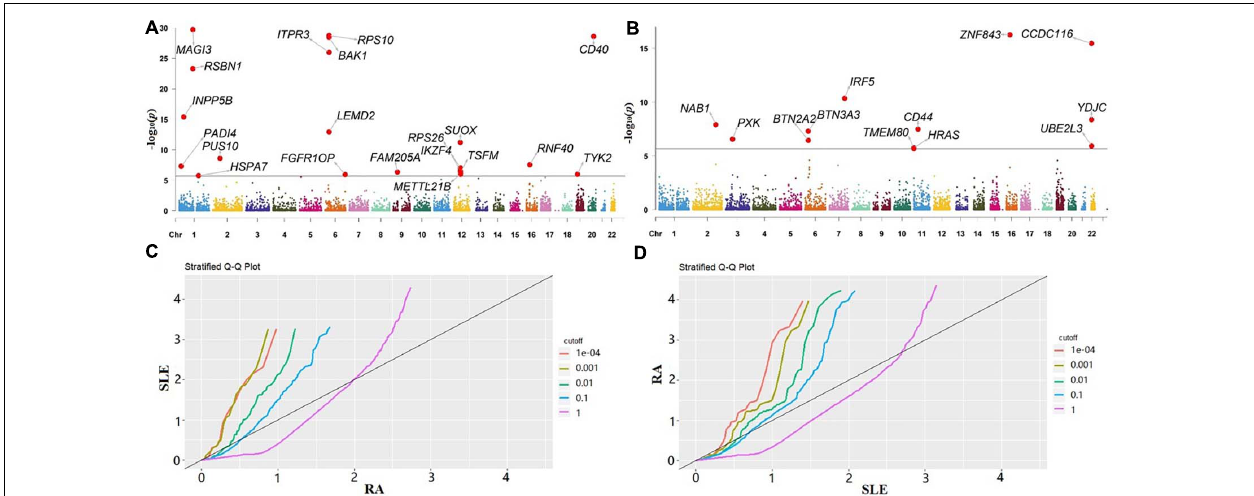
FIGURE 2 | (A) Manhattan plot for RA; (B) Manhattan plot for SLE. The genes in both plots with P -value < 2.1E-06 (the significance level adjusted by Bonferroni’s method) are highlighted; (C) Q-Q plot of RA conditional on the nominal P- value of SLE; (D) Q-Q plot of SLE conditional on the nominal P- value of RA. RA, rheumatoid arthritis; SLE, systemic lupus